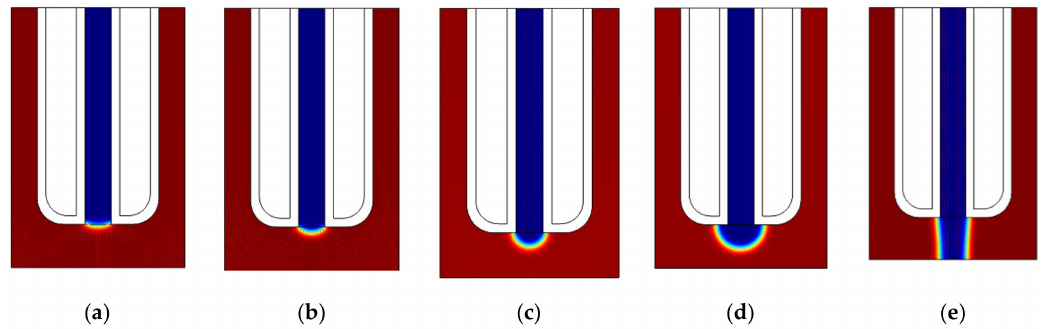
Figure 7. Simulation results at di ff erent extra pressures. ( a ) 0.1 atm. ( b ) 0.8 atm. ( c ) 1.2 atm. ( d ) 1.4 atm. ( e ) 2 atm.